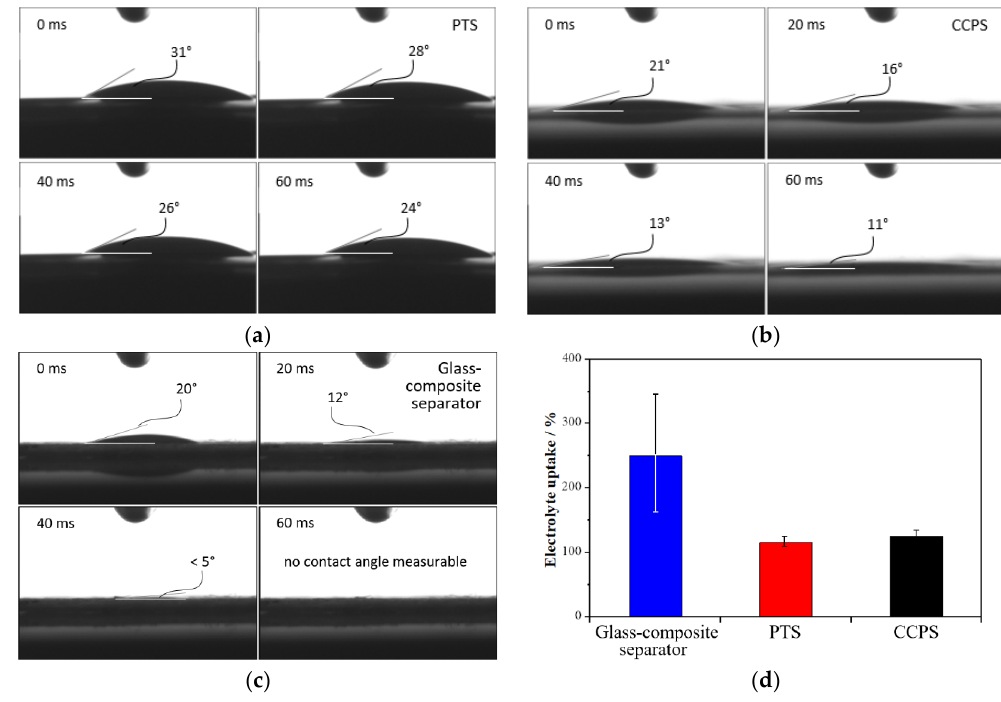
Figure 6. Photographs of the contact angle measured with 10 µL DMC ( a ) polymer trilayer separator (PTS); ( b ) ceramic-coated polymer separator (CCPS); ( c ) glass composite separator; ( d ) electrolyte uptake of glass composite separator compared to PTS and CCPS.